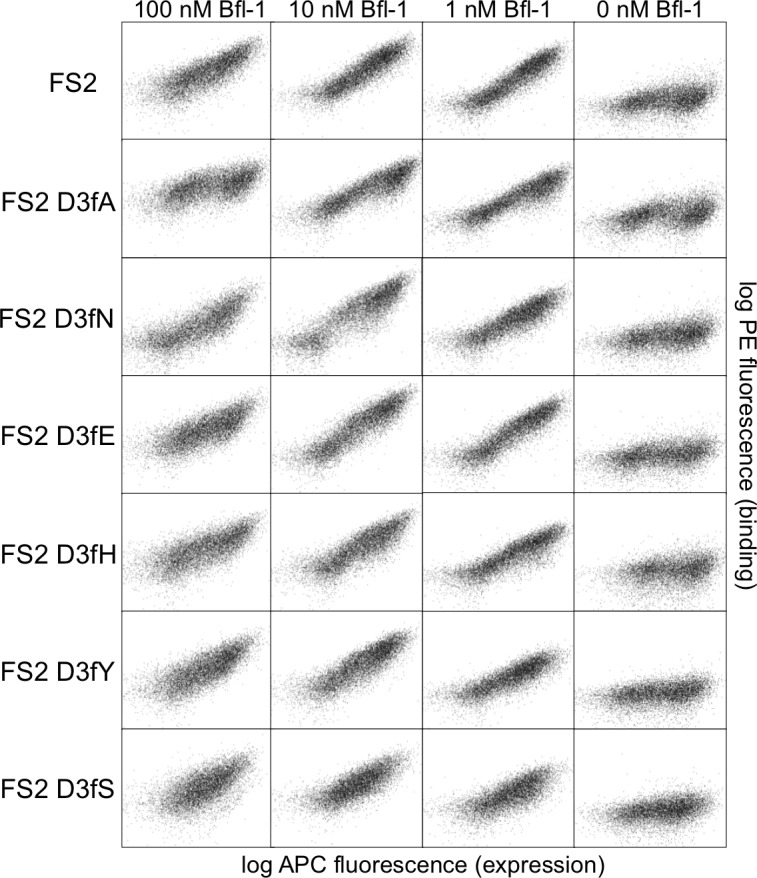
FACS analysis of cells displaying FS2 or FS2 with single point mutants at position 3f.FACS profiles for mutants are nearly indistinguishable from that of FS2. Data were collected the same day with the same settings, and all plots use the same scale of arbitrary units.